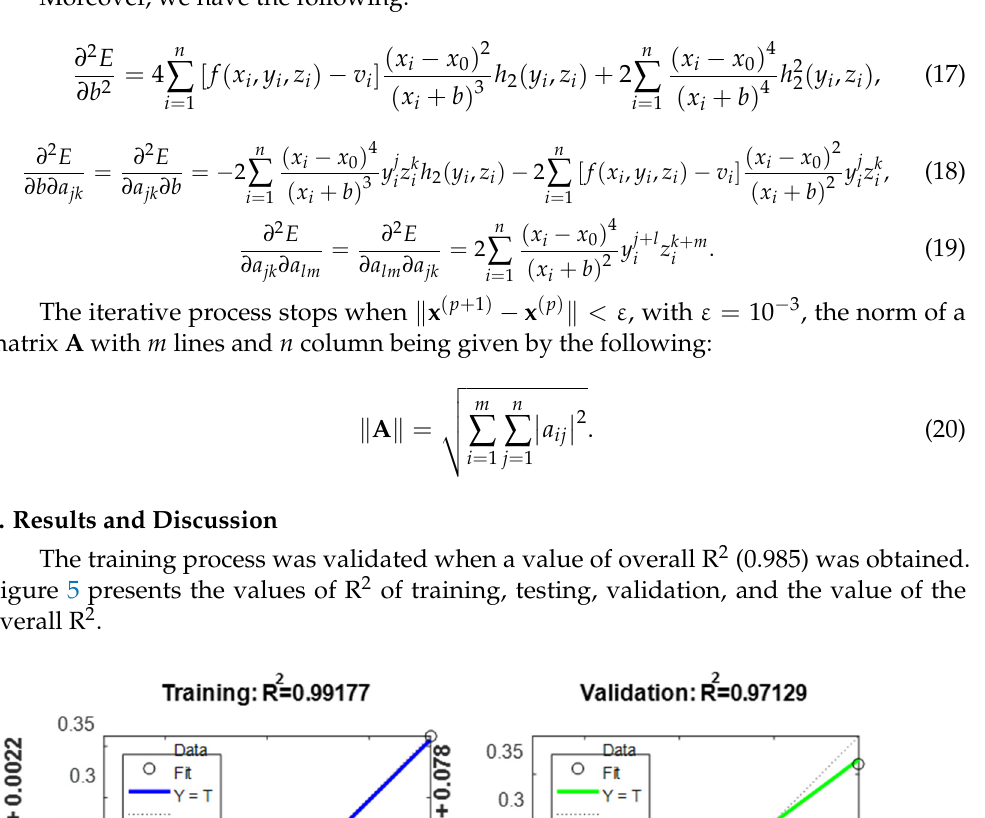
Figure 6. The mean square error plot. M ea n S qu a r e d E rr o r ( m se )